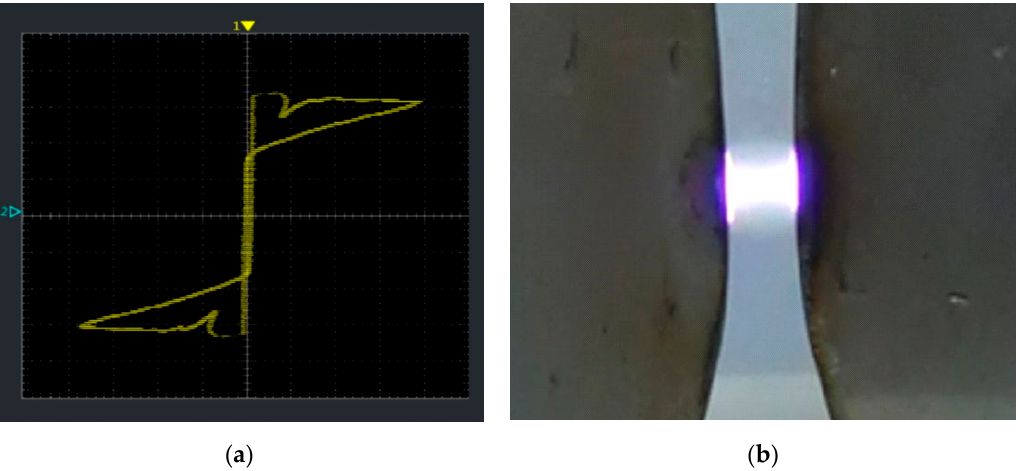
Figure 4. Discharge in the ignition space of the two-knife shaped electrodes of μ GAD under atmospheric pressure, ( a ) dynamic characteristics i ( t ) = f [ u ( t )], where: signal 1: u GA ( t ): 200 V/div, signal 2: i GA ( t ) 50 mA/div, ( b ) discharge photo.